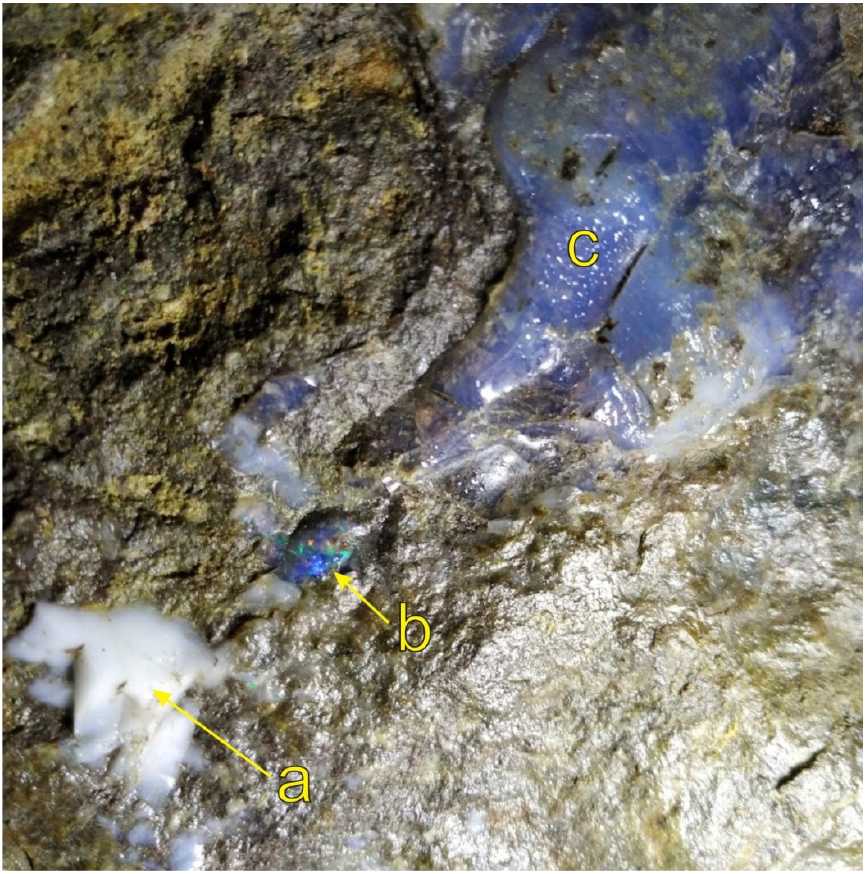
Figure 4. Opal mineralization of the Libanka mining district, ( a ) milk opal, ( b ) precious opal, ( c ) glassy opal (photo by Ľ ubomír